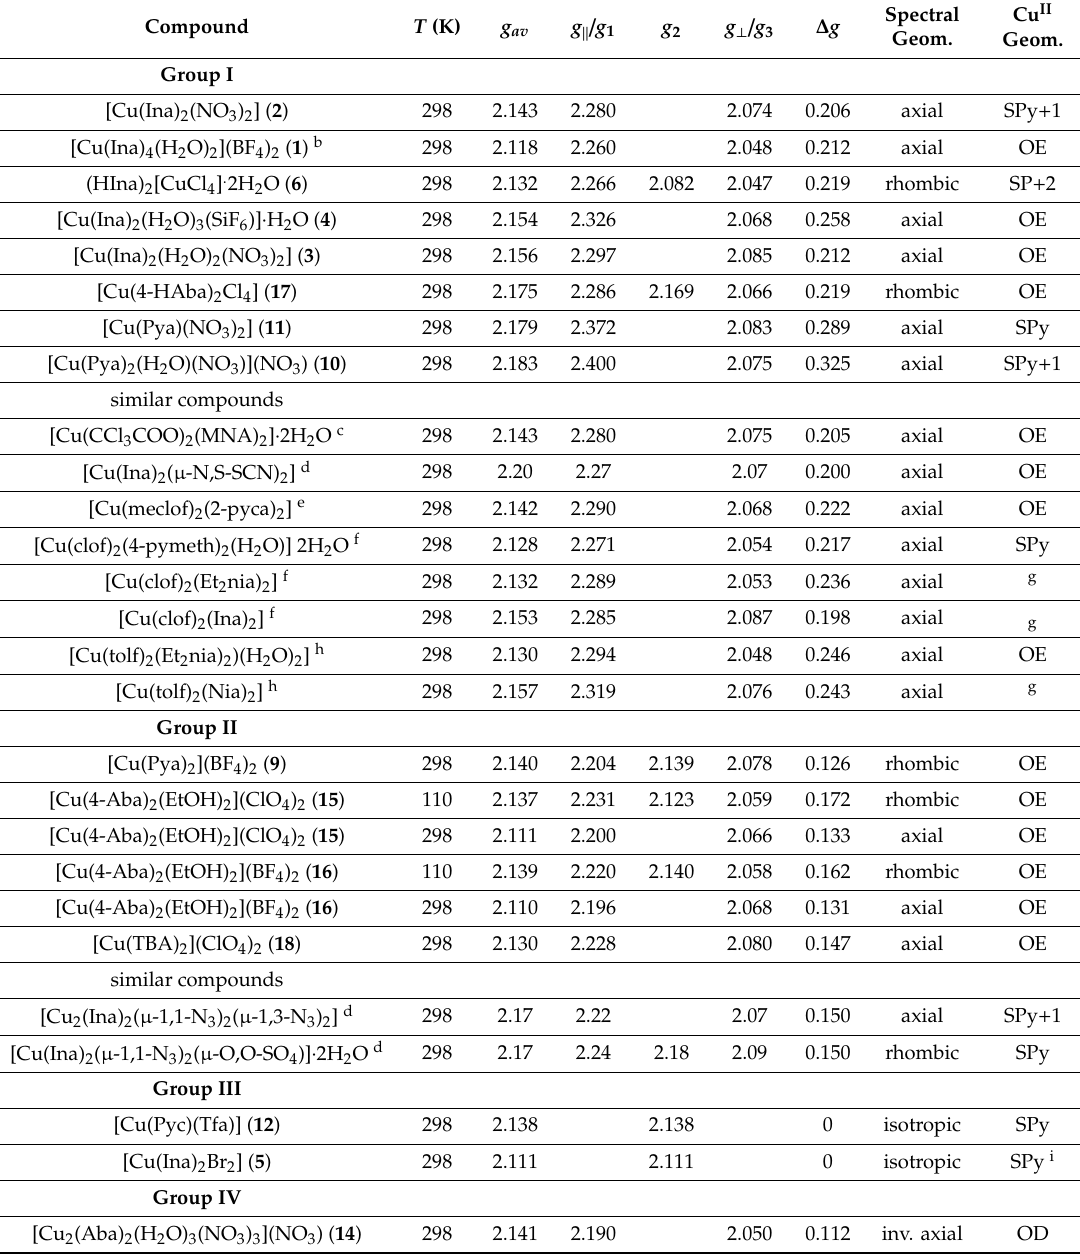
Table 3. Selected X-band EPR data of Cu II compounds.